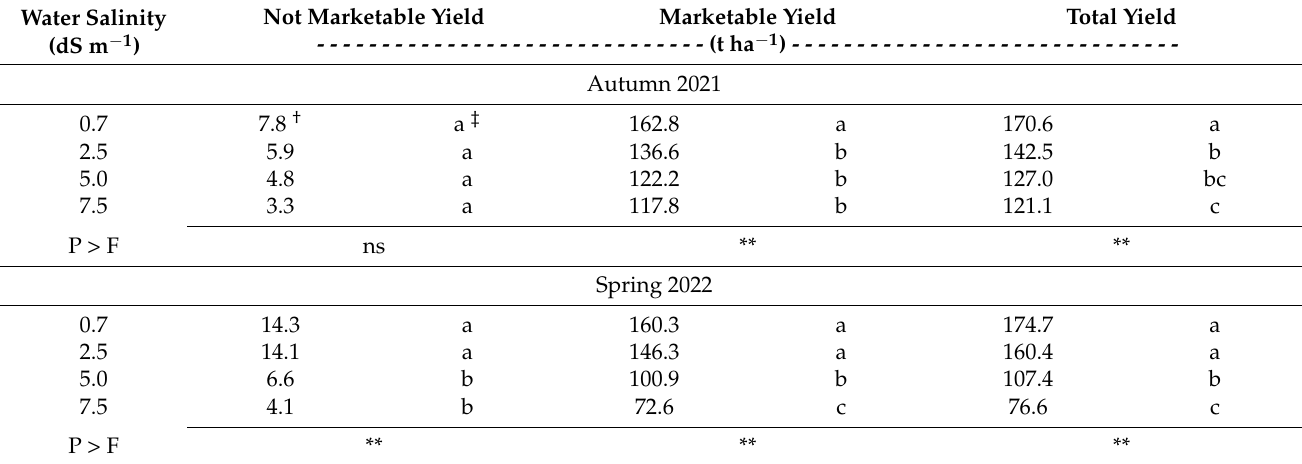
Table 2. The effect of irrigation water salinity on yield components.